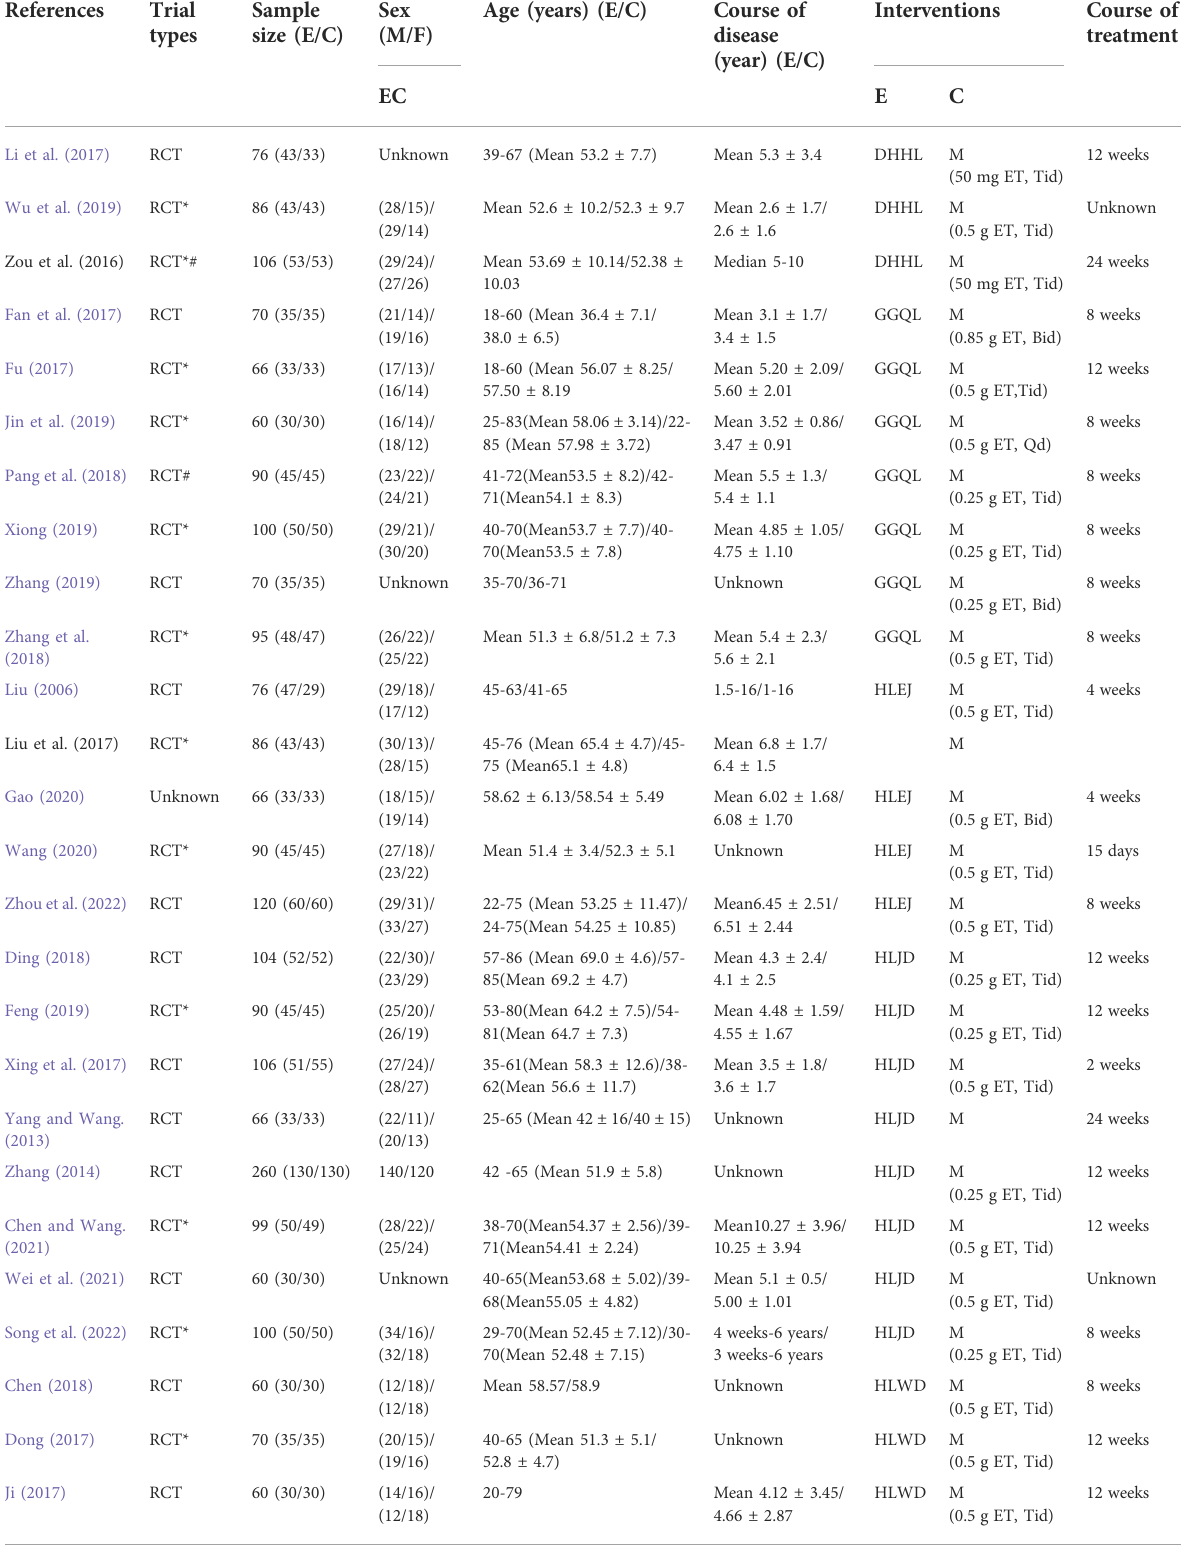
TABLE 1 Characteristics of the included